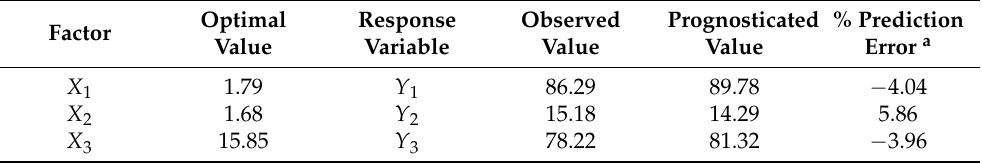
Table 5. Composition, observed and prognosticated responses for the optimized PRZ-PMMs formulation.